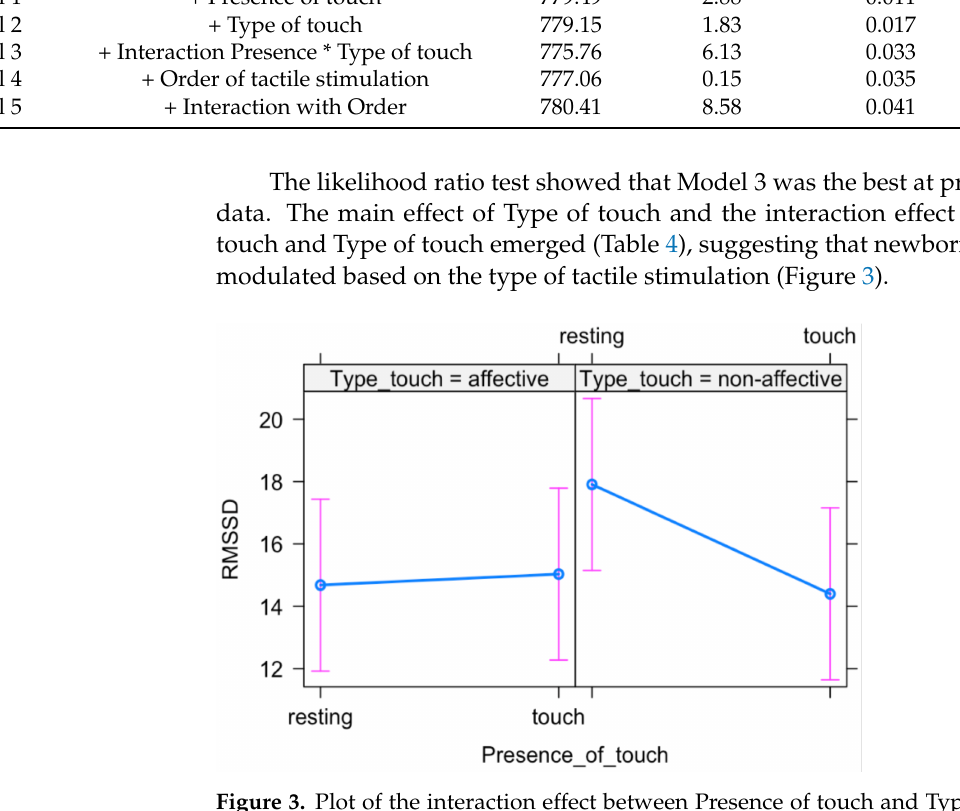
Figure 3. Plot of the interaction effect between Presence of touch and Type of touch. Mean (blue dots) and standard errors (pink lines) are displayed for both resting and tactile stimulation in each experimental condition (affective vs.